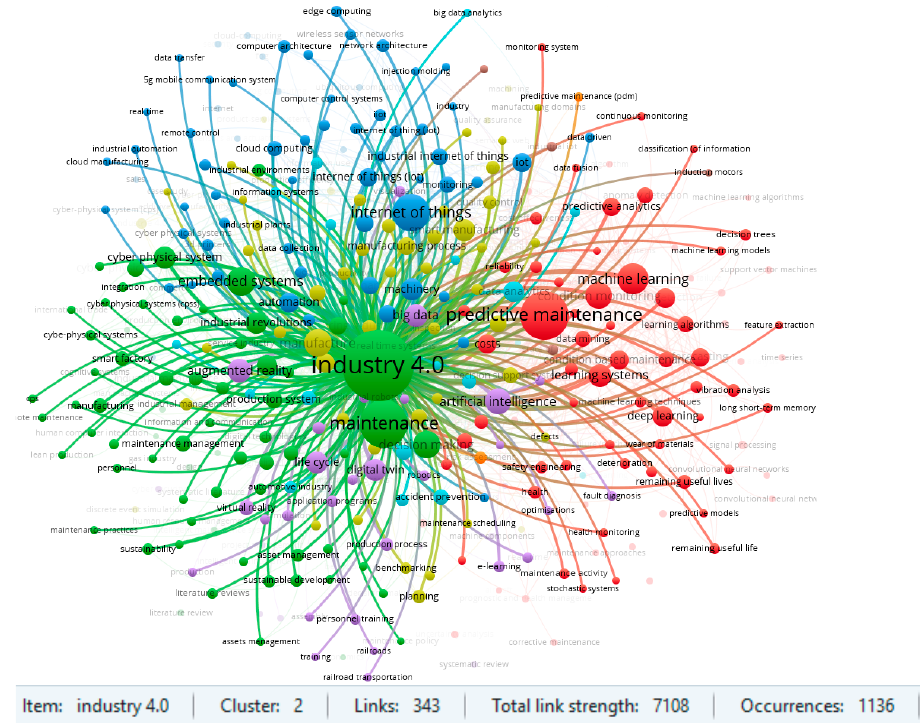
Figure 18. Analysis of keyword strength for the second cluster of publications from the Scopus database. Source: own development using VOSviewer software [101].